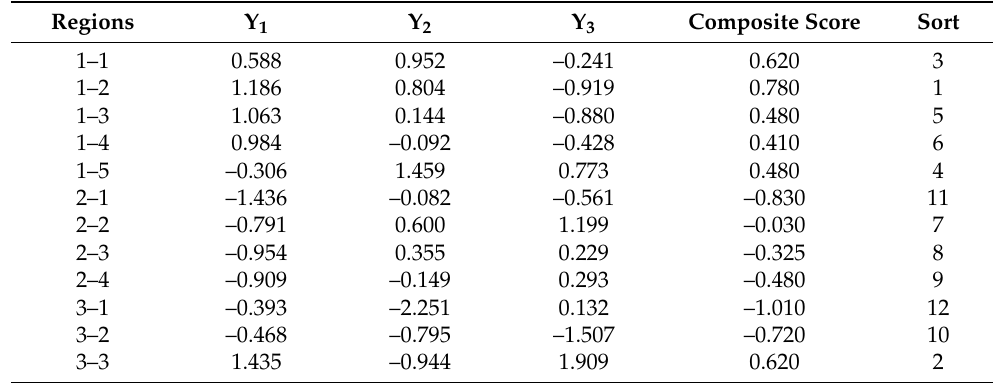
Table 20. Comprehensive score and ranking of the amino acid evaluations of fresh corn in three regions.